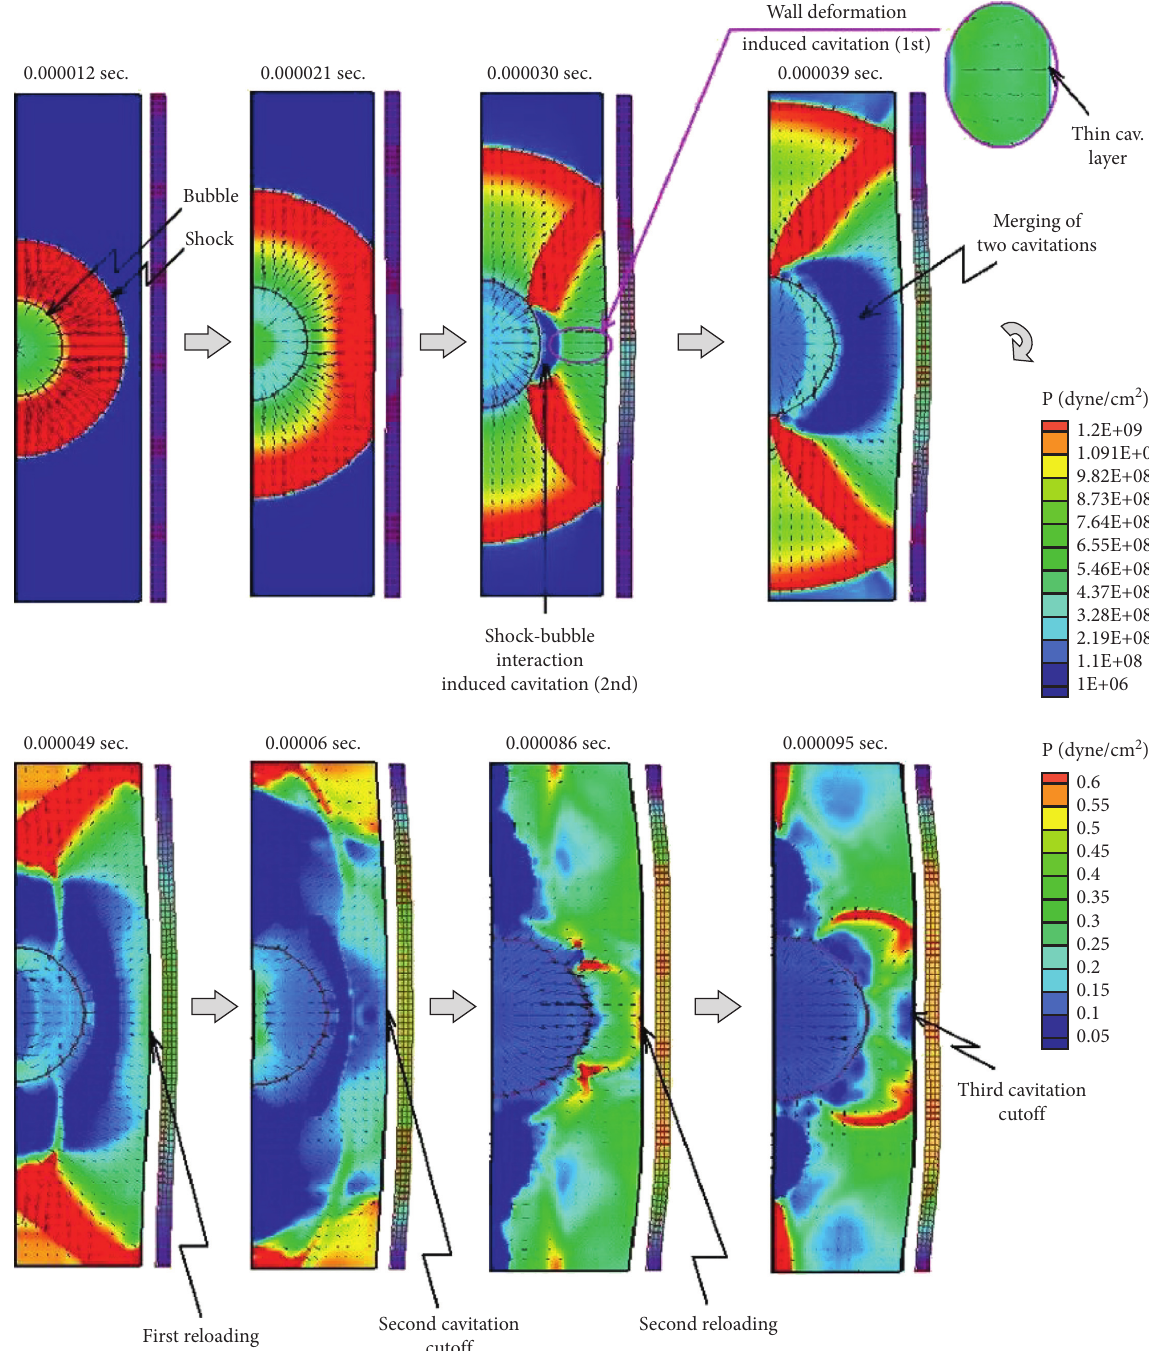
Figure 28: Pressure contours inside the deformable wall tube of half Figure 28 are reproduced from “Application of the Runge–Kutta Discontinuous Galerkin-Direct Ghost Fluid Method to internal explosion inside a water-filled tube, 2019” [33].